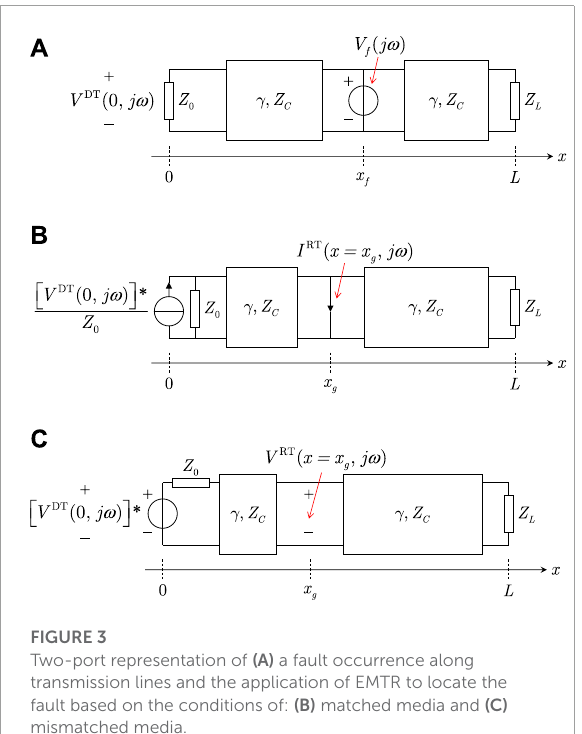
FIGURE 3 Two-port representation of (A) a fault occurrence along transmission lines and the application of EMTR to locate the fault based on the conditions of: (B) matched media and (C) mismatched